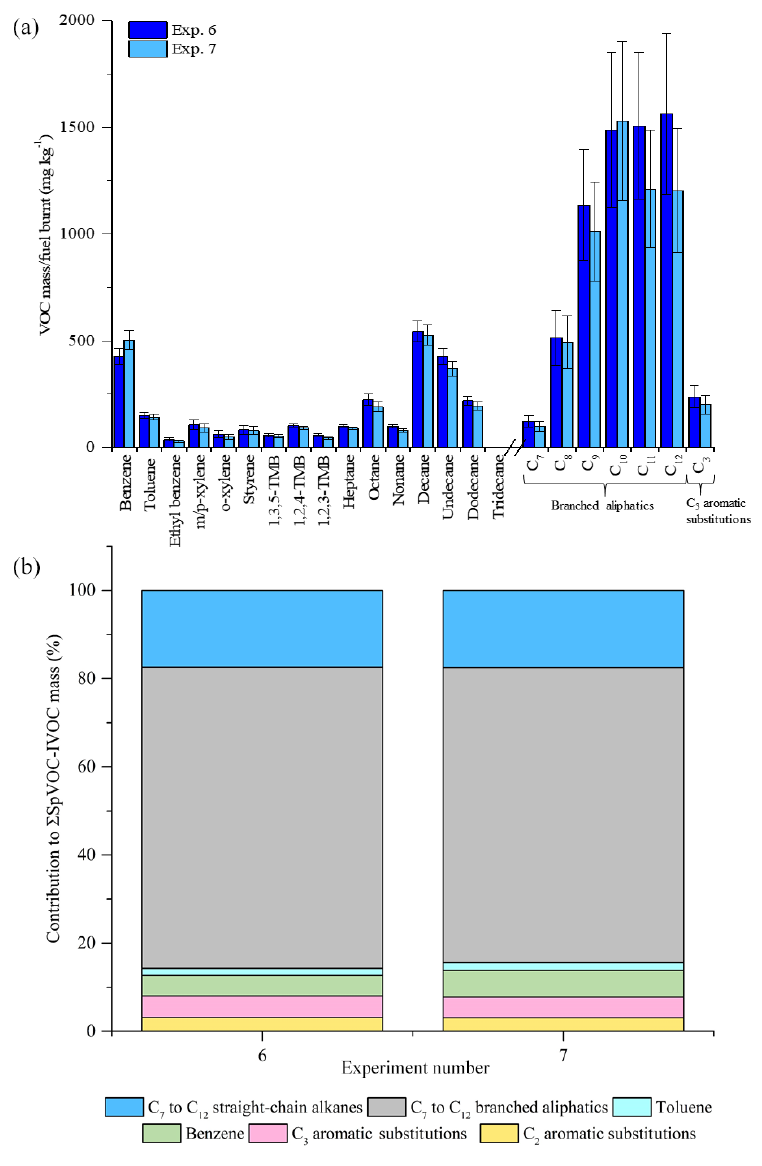
Figure 3. Comparison of measured VOC-IVOC emission rates in replicate cold-start experiments (exps. 6 and 7) (a) . Comparison of the percentage contribution of the individual and grouped compounds to the P SpVOC-IVOC emission rates in exps. 6 and 7 (b) . The emission rates of tridecane and the C 13 branched aliphatic grouping has not been included in (b) to allow direct comparison between other experiments where these species were not measured. Error bars represent the calculated uncertainty in the measured emission rates, see Sect. S1.1 in the Supplement for further